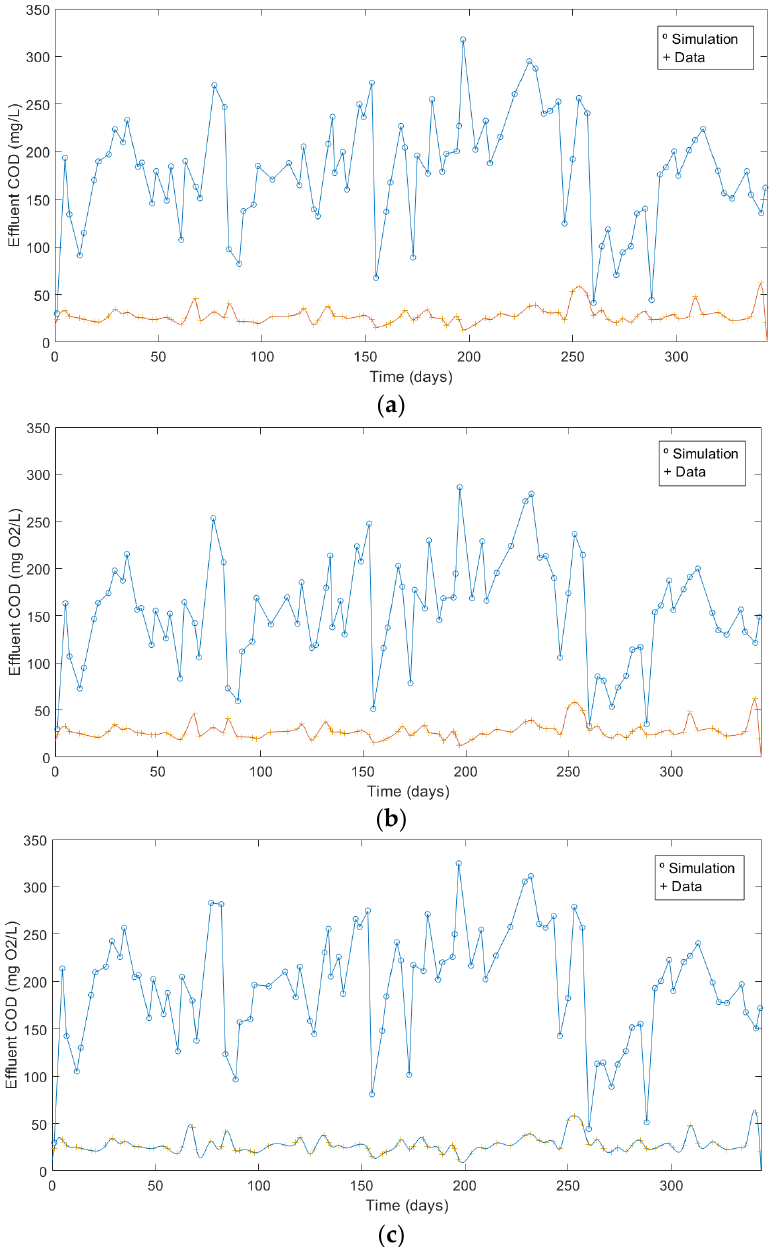
Figure 3. Tuning on Y H for μ H , max = 0.1 d −1 . ( a ) Y H = 0.6, ( b ) Y H = 0.5 and ( c ) Y H = 0.7. Blue upper line is simulation data and coloured lower line is the evolution of real values (analysed data) after biological treatment in the WWTP (Table 3, COD (mg/L)).